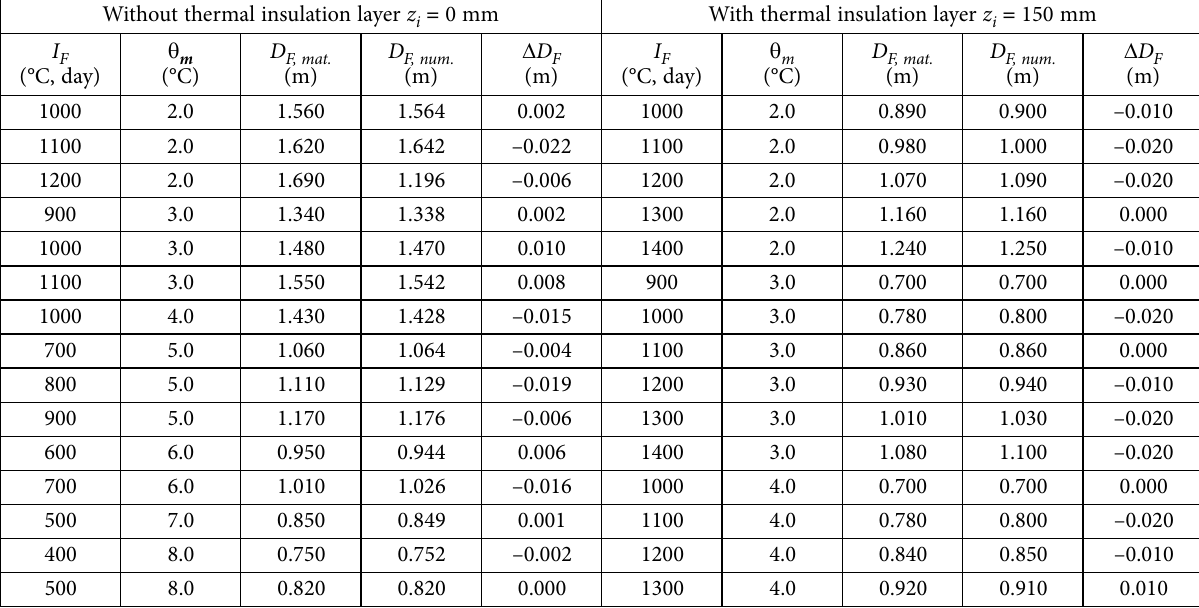
Table 3. Deviations of the values determined by mathematical and numerical methods for the depth of freezing of the railway track structure D F as a function of the air freezing index I F and the average annual air temperature θ m (sub-ballast layers without thermal insulation layer and with built-in thermal insulation layer made of foam glass of 150 mm thickness) Without thermal insulation layer z i = 0